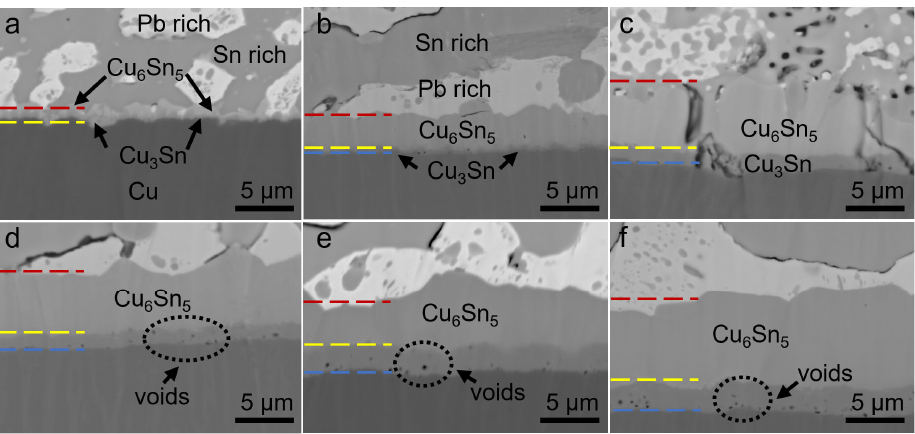
Figure 8. Cross-section SEM images of the solder–pad interface under the aging of ( a ) 0 day, ( b ) 4 days, ( c ) 16 days, ( d ) 25 days, ( e ) 36 days, ( f ) 49